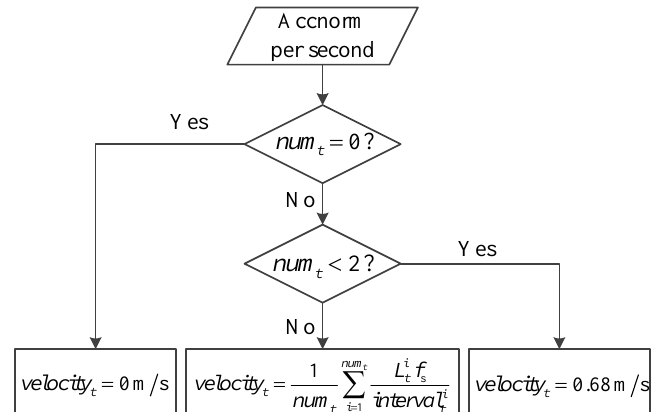
Figure 4. Block diagram of velocity calculation.